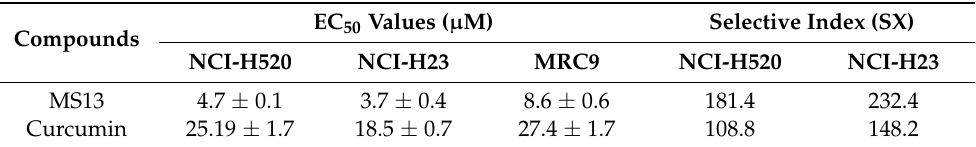
Table 1. EC 50 values of curcumin and MS13 on NCI-H520, NCI-H23, and MRC9 cells and their selective indices. Compounds